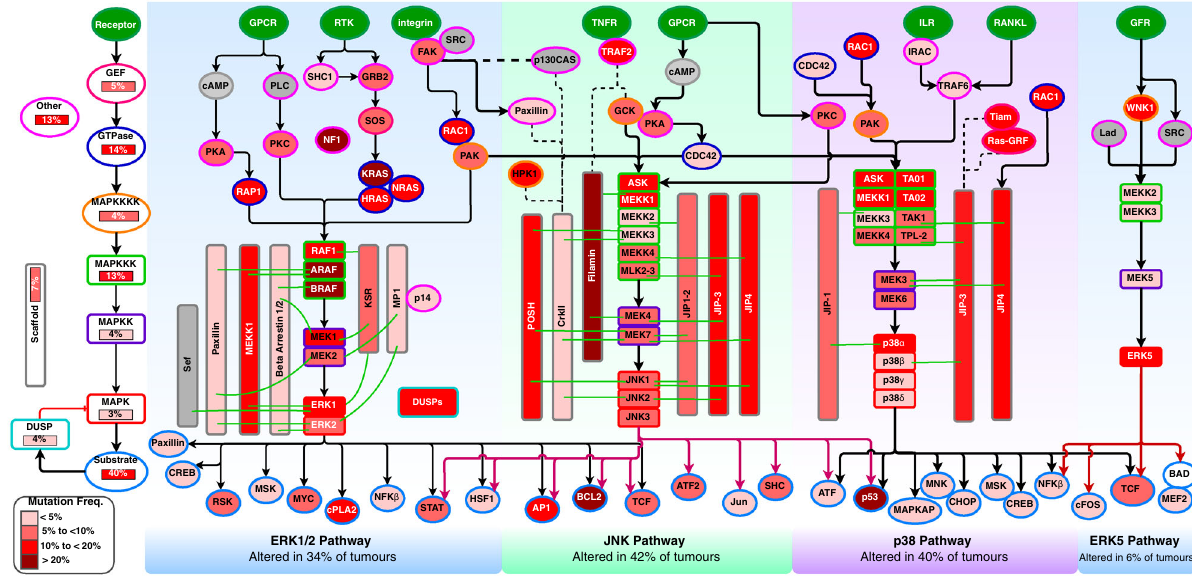
Fig. 1 Mutations of MAPK pathway genes. The nodes represent genes of the four MAPK pathway modules (the ERK1/2, p38, JNK and ERK5 pathways). The outline colours represent the classes of MAPK proteins that are encoded by particular genes, as shown on the left side of the fi gure. The abbreviations are as follows: GEFs guanosine exchange factors, GTPase Guanosine triphosphatase, MAPKKKK mitogen-activated protein kinase kinase kinase kinase, MAPKKK mitogen-activated protein kinase kinase kinase, MAPKK mitogen-activated protein kinase kinase, MAPK mitogen-activated protein kinase, DUSP dual-speci fi city phosphatase, Other; proteins other than those described above. Node colours represent the frequencies of gene mutations, and their increasing colour intensities denote higher percentages of tumours with mutations in genes encoding MAPK pathway proteins. In order clearly show the cancer-type mutations in the MAPK genes, we have presented the maximum gene alteration seen speci fi c cancer types for each gene. This is because the mean gene mutation frequencies do not show how certain cancer types tend to have mutations in different MAPK genes. Additional, both the mean gene mutations across cancer types and the cancer-type maximum mutation rate in each speci fi c MAPK pathway gene are given in Supplementary File 1 in the sheet named “ Speci fi c MAPK Gene Mutations ” . Edges indicate known types of interaction: red for inhibition, black arrows for activation, dotted lines for physical protein-protein interactions and green lines for interaction with scaffold proteins. To make the visualisation clearer, we have omitted some interactions between some network nodes. See Supplementary Fig. 1 for the complete connectivity network of all the MAPK pathway